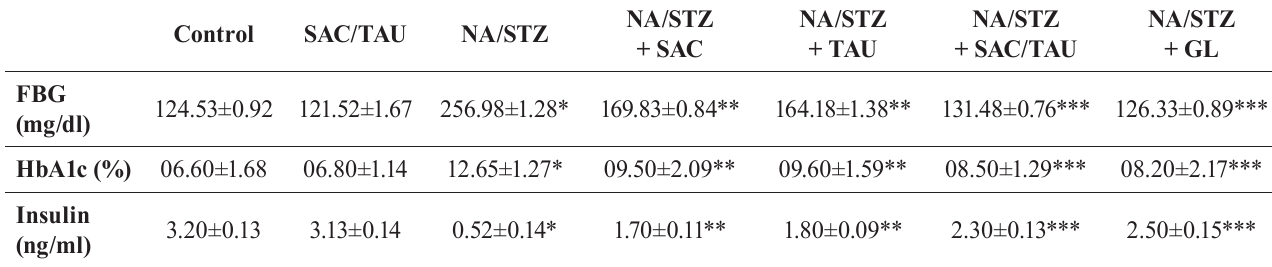
TABLE I - E ffect of SAC, TAU and SAC/TAU treatment on FBG, HbA1C and insulin in T2DM